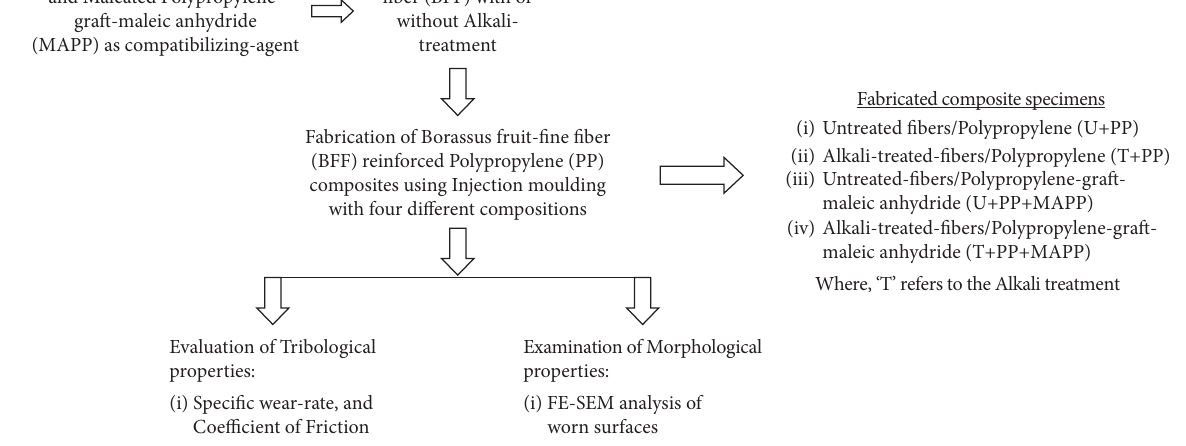
Figure 4: Proposed research